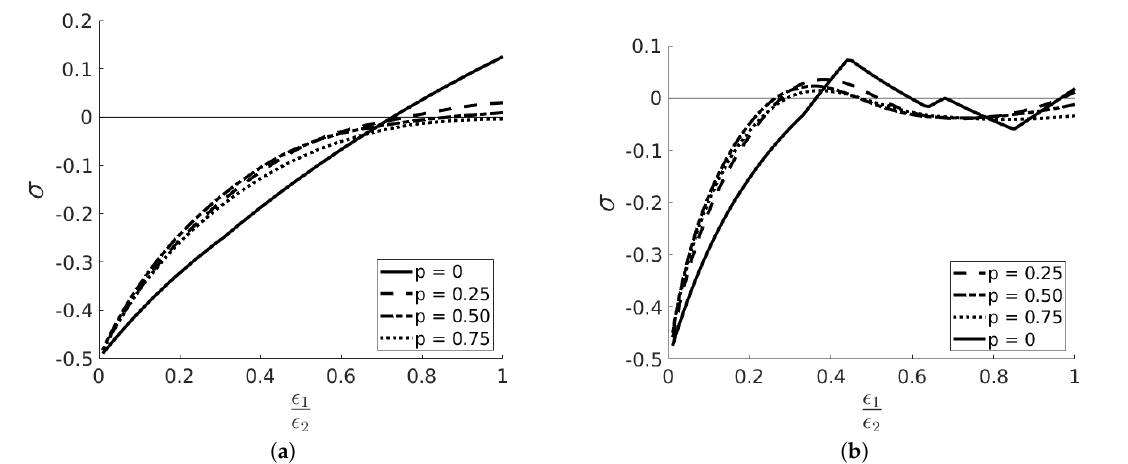
Figure 7. ( a ) “Square” city with periodic boundary conditions and different absorbancy ( (cid:101) 1 = 1). For large enough asymmetry p , there is an intransitive region near ( (cid:101) 2 = 1). ( b ) Same city but with reflecting boundary conditions, here one observes an intransitive region for intermediate values of (cid:101) 2 . The curve with p = 0 is different from other since in this case one doe not have to average over different realizations (1000) of the choice of one-way